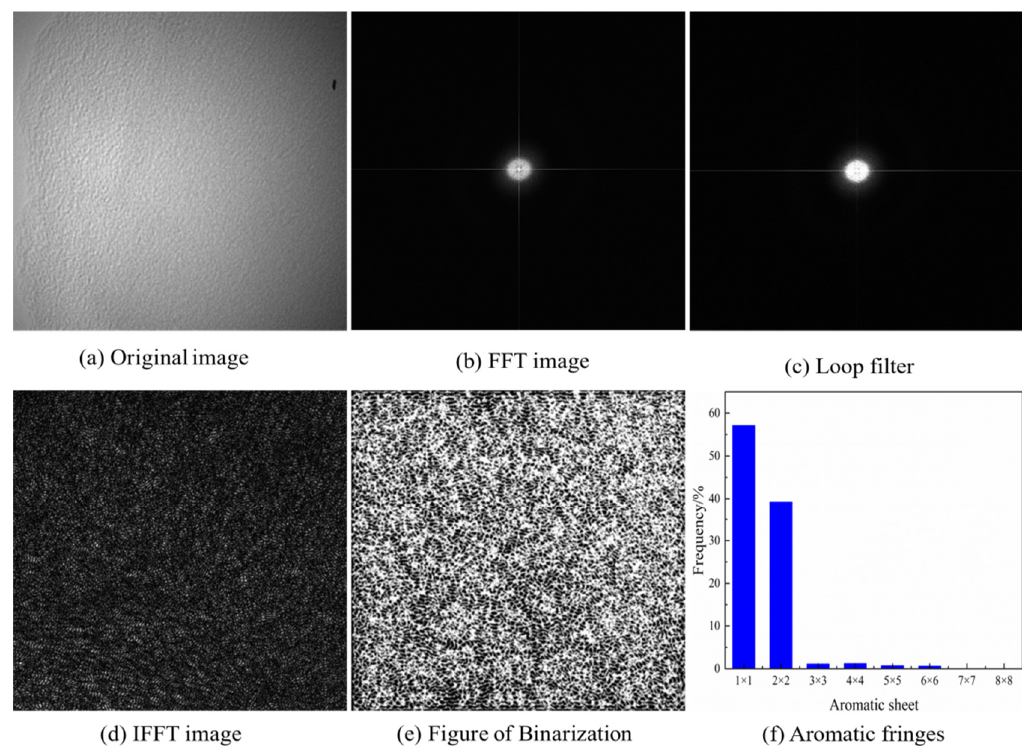
Figure 3. Image analysis process ( a – e )and aromatic fringe distributions ( f ) of Kerjian coal.